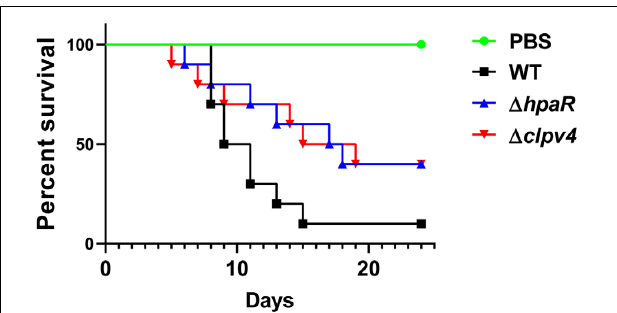
FIGURE 6 | Yptb mutants lacking hpaR or T6SS4 are defective in virulence against mice. Bacterial strains grown in YLB were washed twice in sterilized PBS and used for orogastric infection of 6–8 weeks old female C57BL/6 mice using a ball-tipped feeding needle. For survival assays 3 × 10 9 bacteria of each strain were applied to different groups of mice ( n = 10/strain), and the survival rate of the mice was determined by monitoring the survival daily for 24 days.